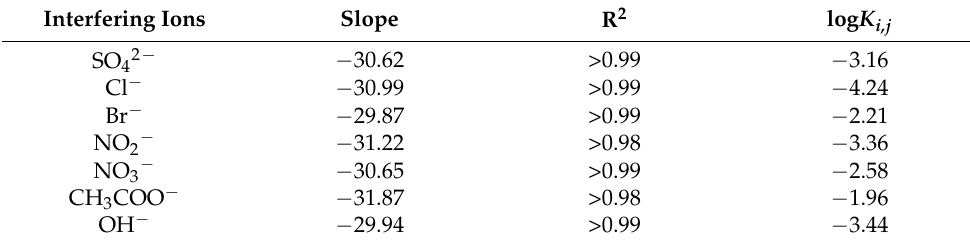
Table 2. Selectivity factor measured for the carbonate electrode by the IFM. Interfering Ions Slope R 2 log K i,j SO 42